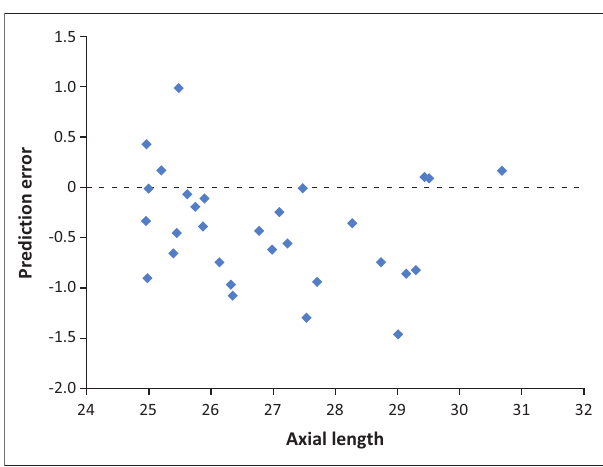
FIGURE 6: Axial length versus prediction error in group